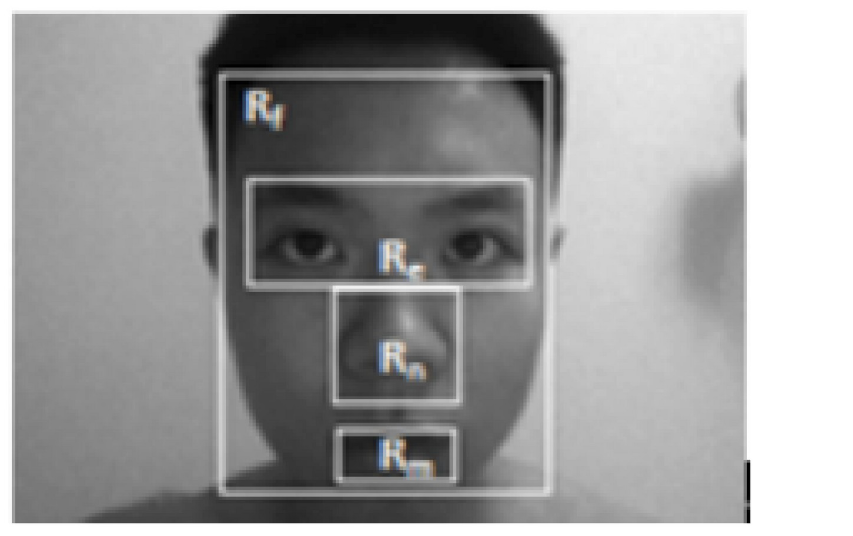
Fig 12. Face separation [49].